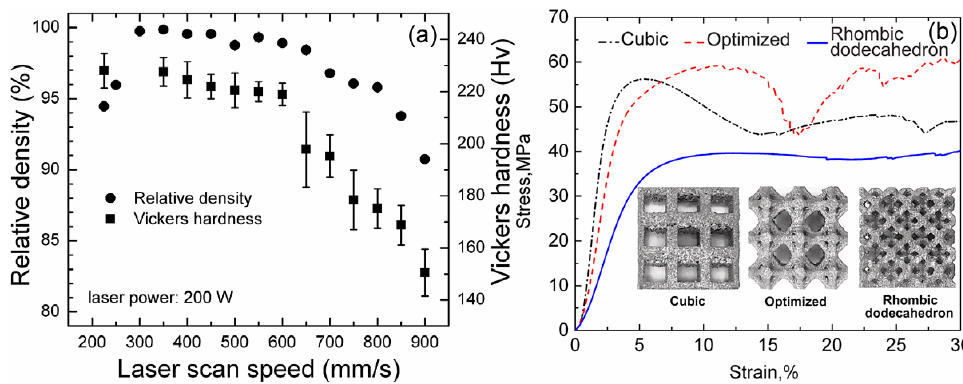
Figure 2. ( a ) Density and Vickers hardness of Ti–24Nb–4Zr–8Sn samples and ( b ) typical compressive stress–strain curves of Ti–24Nb–4Zr–8Sn alloys with cubic, topology-optimized, and rhombic dodecahedron structures. (Reproduced with permission from refs. [25,159]. Copyright (2011, 2018), Elsevier).